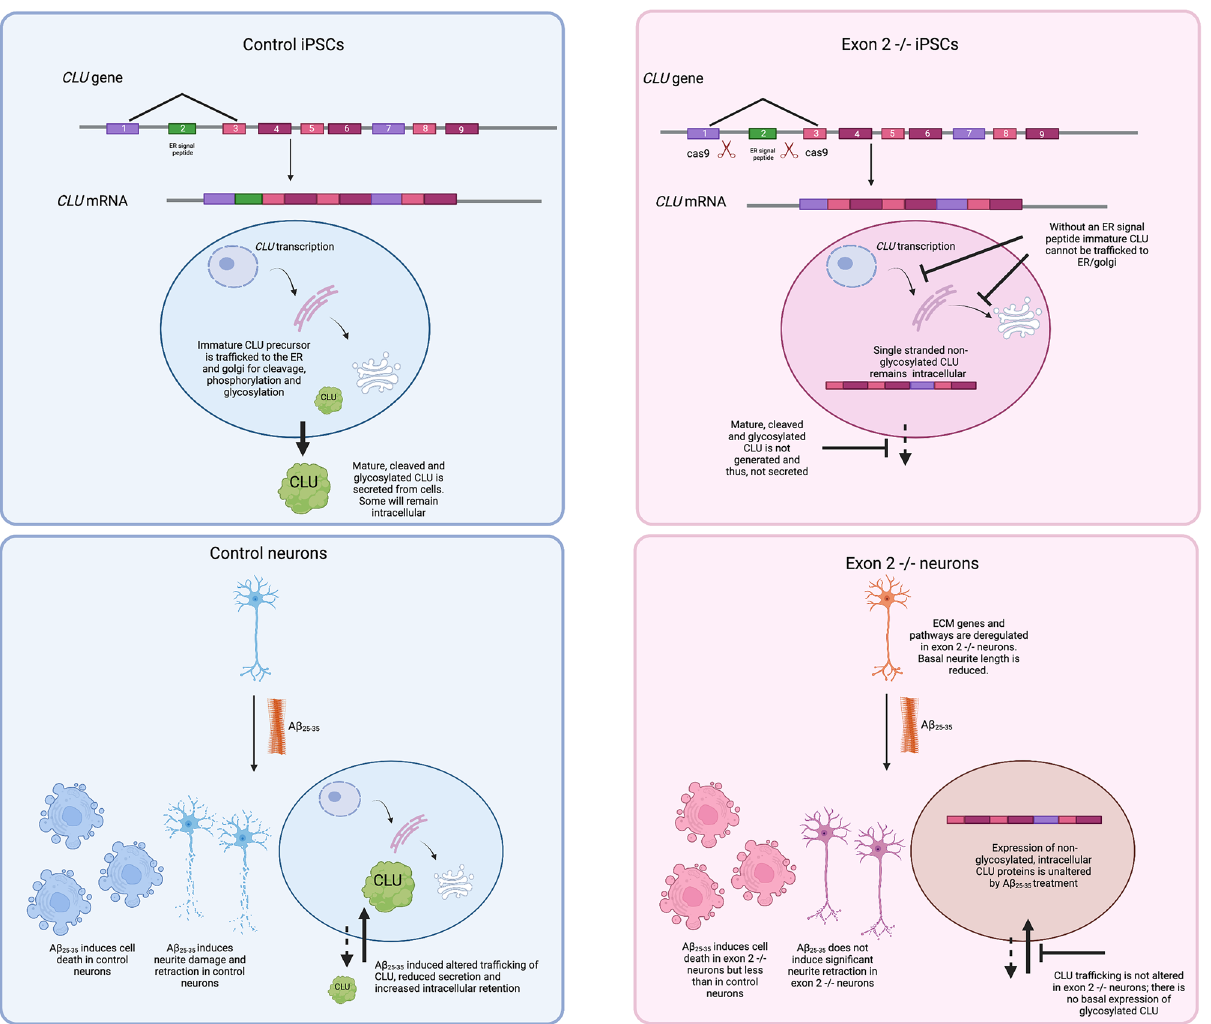
Figure 5. Summary diagram. Graphic illustration highlighting key results observed in this study. To alter the type and localisation of CLU proteins generated by iPSCs CRISPR/Cas9 gene editing was used; iPSCs lacking CLU exon 2 do not produce mature, glycosylated and cleaved CLU proteins and therefore do not secrete CLU proteins. Instead, exon 2 −/− iPSCs generate single polypeptide CLU protein that does not undergo glycosylated and remains intracellular. Following differentiation of CTR and exon 2 −/− iPSCs into neurons, neurons were treated with Aβ 25–35 and phenotypes compared to assess if altered CLU protein production alters the sensitivity of neurons to Aβ 25–35 induced toxicity. Aβ 25–35 treatment induced significant cell death and neurite damage to control neurons, this was accompanied by an alteration in CLU trafficking resulting in increased intracellular retention and reduced secretion of glycosylated CLU proteins. CLU trafficking was not altered in exon 2 −/− neurons since they do not express glycosylated CLU proteins. In contrast to previous reports, no evidence was found that non-glycosylated CLU protein abundance is increased following induction of stress or cell death. Exon 2 −/− neurons displayed significant cell death following Aβ 25–35 treatment but no significant neurite damage was observed. We suggest that the partial protection displayed by exon 2 −/− neurons may be attributed to the altered expression and activity in extracellular matrix genes and pathways as highlighted by RNA-seq analysis. Diagram created with